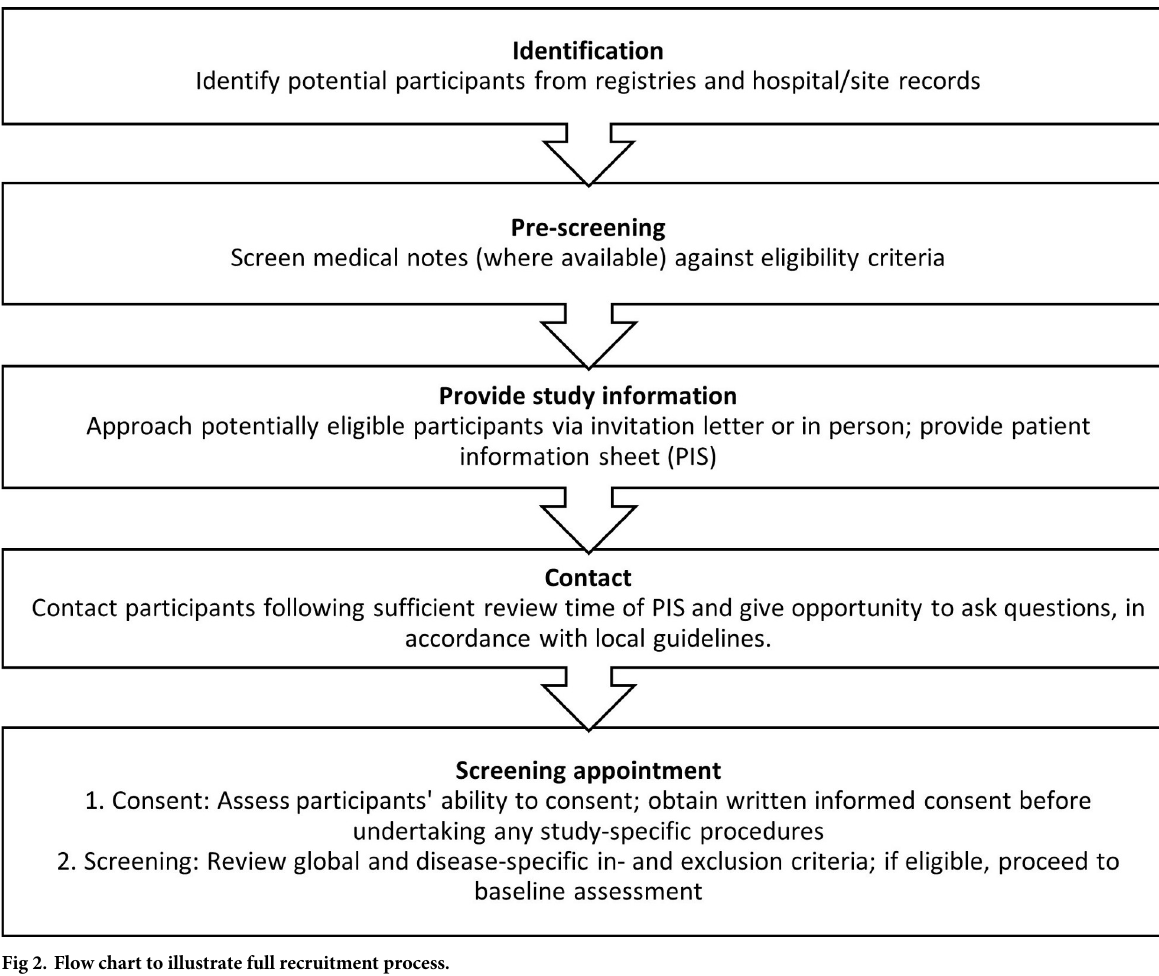
Fig 2. Flow chart to illustrate full recruitment